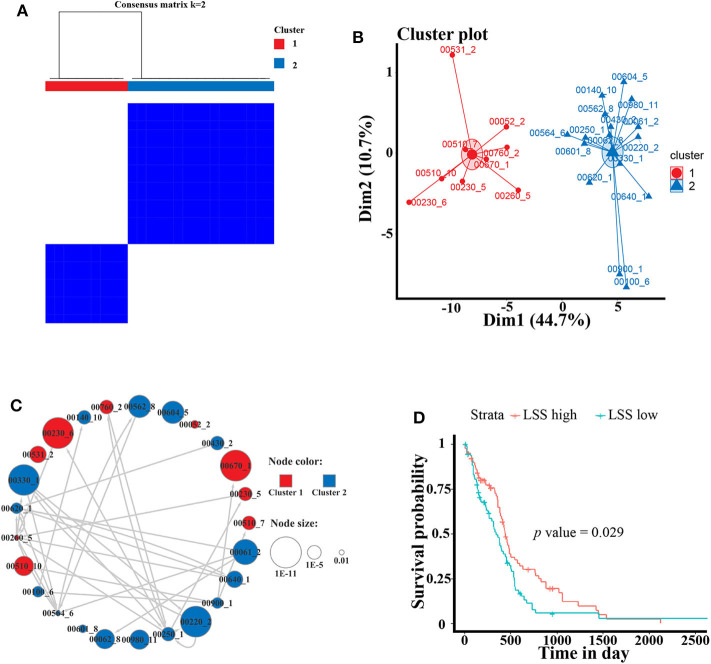
Cluster analysis of GBM-related metabolic subpathways and the survival analysis curve of key genes LSS. (A) Consistent clustering and (B) K-means clustering results of 25 GBM-related metabolic subpathways in GSE4290 data set. (C) The GBM-related metabolic subpathway relationship network map is manually drawn according to the functional relationship between the pathways in the KEGG database. The size of each node represents the significance of the difference in the activity scores of the sub pathways. The color represents the category of clustering. Arrows represent metabolic subpathway linked to other metabolic sub pathways and it is upstream of the linked metabolic subpathways. (D) Survival curve of the gene LSS of metabolic subpathway 00100_6 in TCGA GBM data set.